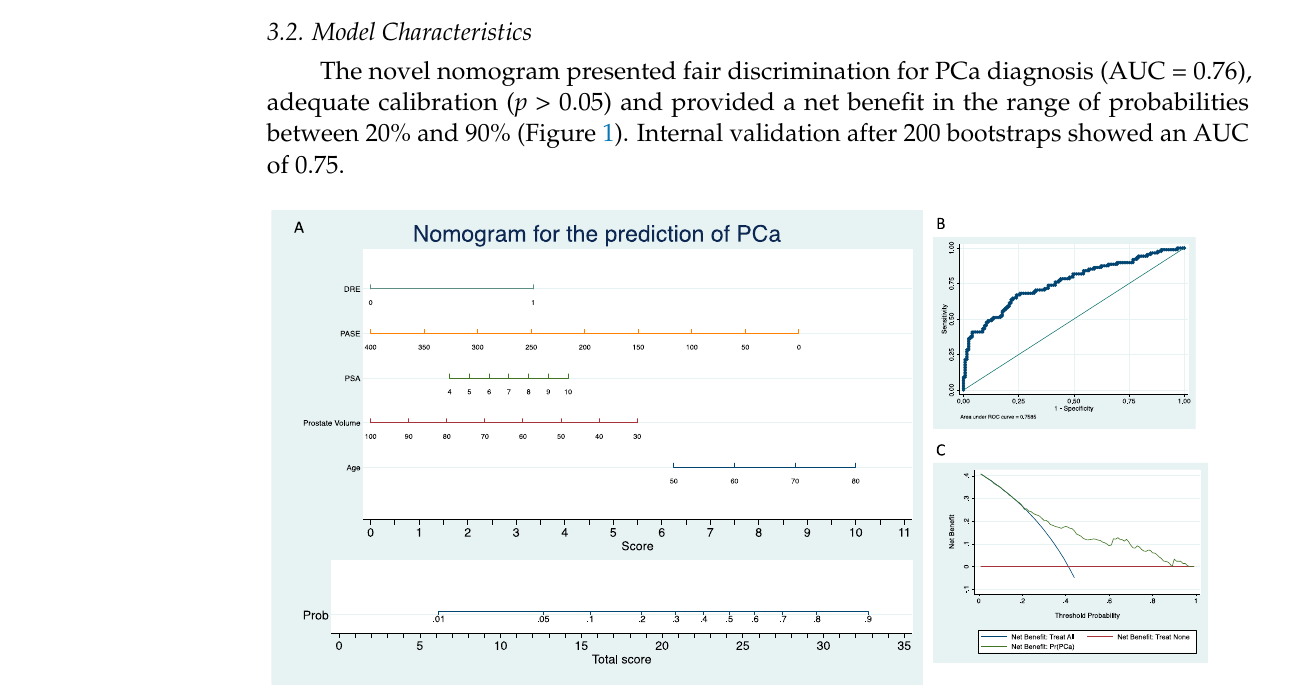
Figure 1. Clinical nomogram to predict prostate cancer diagnosis ( A ) and its related ROC curve ( B ) and DCA ( C ).